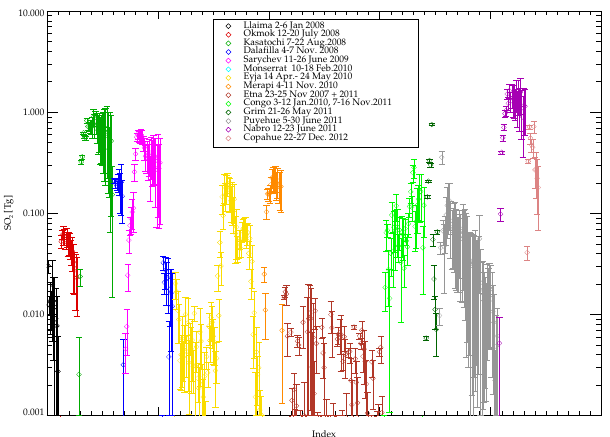
Figure 7. SO 2 mass present in the atmosphere as retrieved from IASI data. The values are the measured amount every half day and vary with volcanic emission, gas removal and satellite sampling. Points are separated by ∼ 12h. Data are presented in temporal or- der along the ordinate ( x axis) but eruptions are plotted consecu- tively one after the other without a gap between them. The total SO 2 amount reported here is computed using the geographic area associated with the eruption. For eruptions which overlap in time (e.g Grimsvötn, Puyehue, and Nabro in May and June 2011) the SO 2 loads within each respective area are considered and plotted